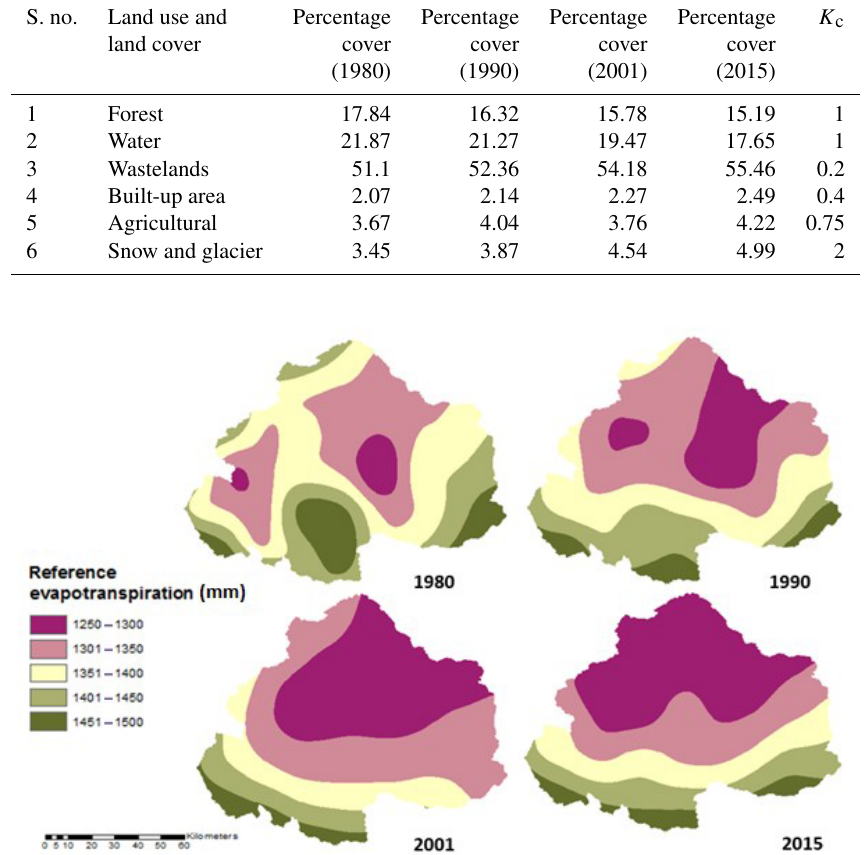
Figure 2. Reference evapotranspiration (mm) of the upper Ganga Basin for the years 1980, 1990, 2001 and